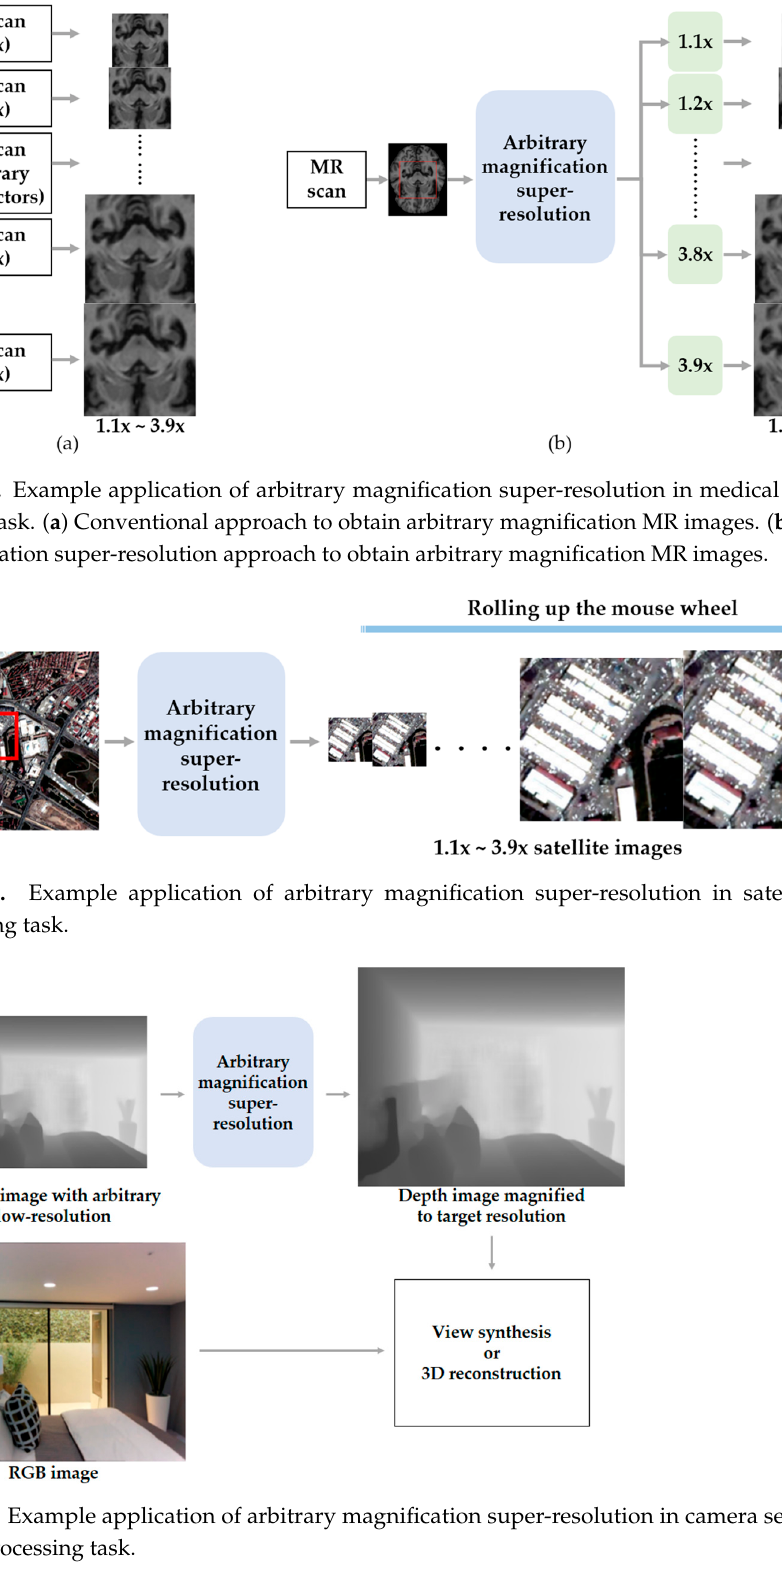
Figure 4. Example application of arbitrary magnification super-resolution in camera sensor depth image processing task.